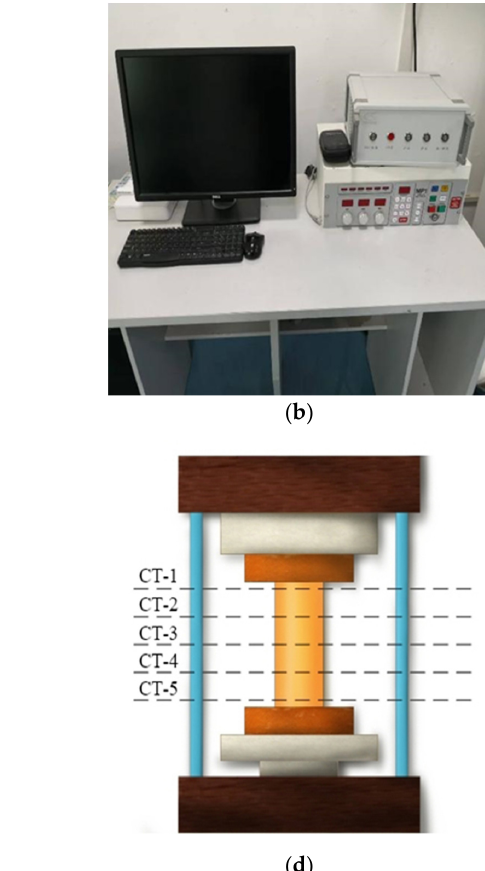
CT images of the first scan section are shown in Figure 3. Figure 3. CT image of the first scan section: ( a ) σ = 0.00 MPa; ( b ) σ = 8.14 MPa; ( c ) σ = 10.30 MPa; ( d ) σ = 14.02 MPa; ( e ) σ = 16.71 MPa; ( f ) σ = 18.85 MPa; ( g ) σ = 19.09 MPa; ( h ) σ = 19.93 MPa; ( i ) σ = 20.5 MPa; ( j ) σ = 21.45 MPa; ( k ) σ = 23.05 MPa; ( l ) σ = 25.88 MPa. It can be seen from Figure 3 of the CT-scan images of the first scanning section at each stage that cracks appeared in the scan images when σ = 18.85 MPa, and no cracks were found in the scan results of the previous stages. When σ = 19.09 MPa~25.88 MPa, the cracks grew steadily, and they finally penetrated in each scanning stage. It can be seen from the CT scanning images of the third scanning section in Figure 4 that the cracks only appeared when σ = 18.85 MPa, and then the time for the cracks to propagate to the final penetration was short and very sudden. When σ = 23.05 MPa~25.88 MPa, there were secondary cracks. This section lagged behind the cracks of the first two sections by two loading stages, indicating that the cracks gradually expanded from top to bottom.